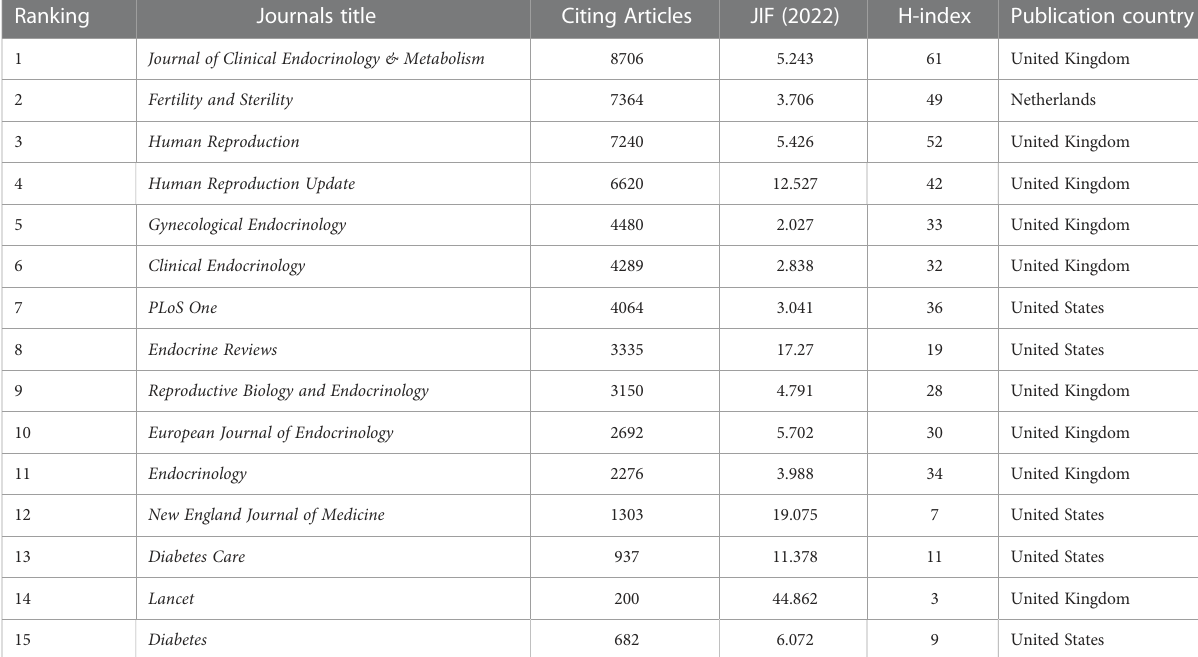
TABLE 1 Top 15 journals with most publications in PCOS research.